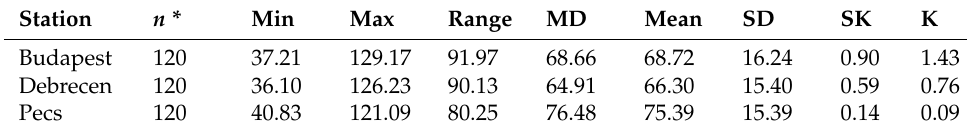
Figure 5. Observed and predicted MFI values when using the ANN–MLP algorithm in the studied station under four scenarios (SC1, SC2, SC3, and SC4): ( A ) evolution of observed and predicted MFIs